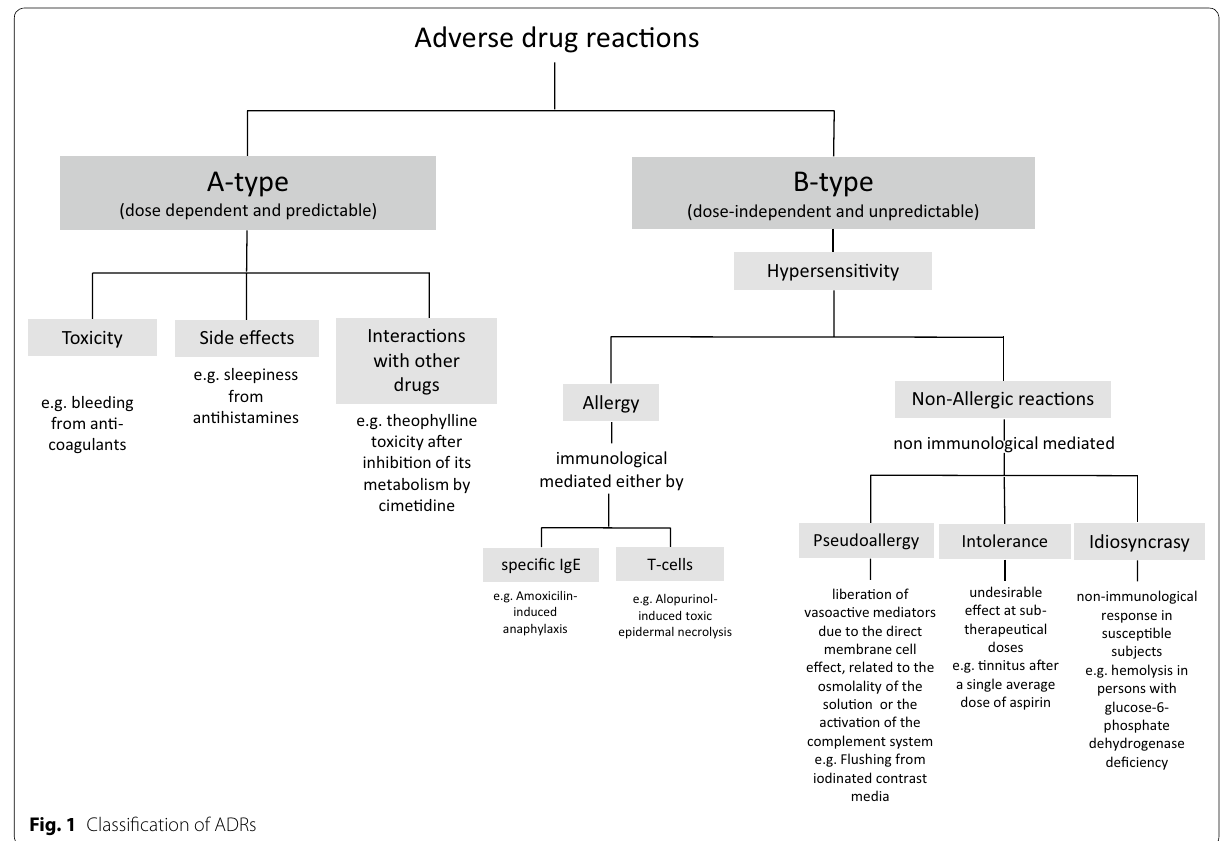
Fig. 1 Classification of